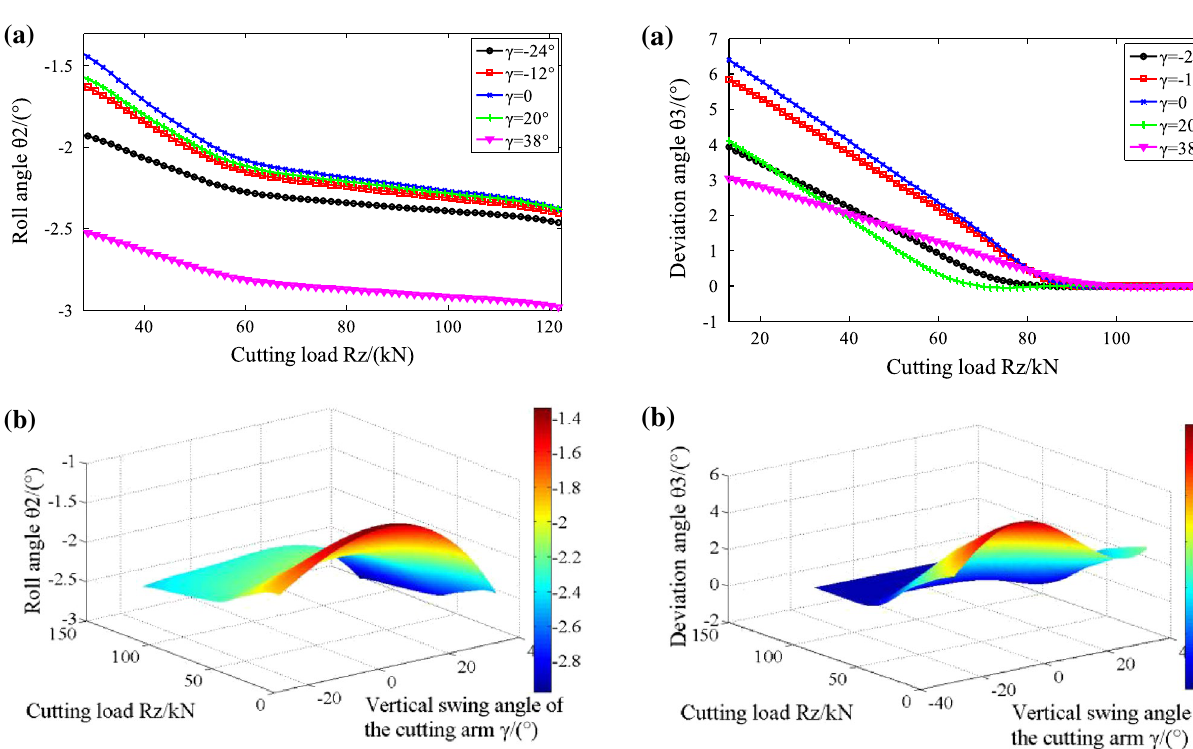
Fig. 15 Response regularities of the deviation angle during the ver- tical cutting process. (a) Relationship between the deviation angle and cutting load [18]; ( b ) Relationship of the deviation angle, cut- ting load and vertical swing angle of the cutting arm